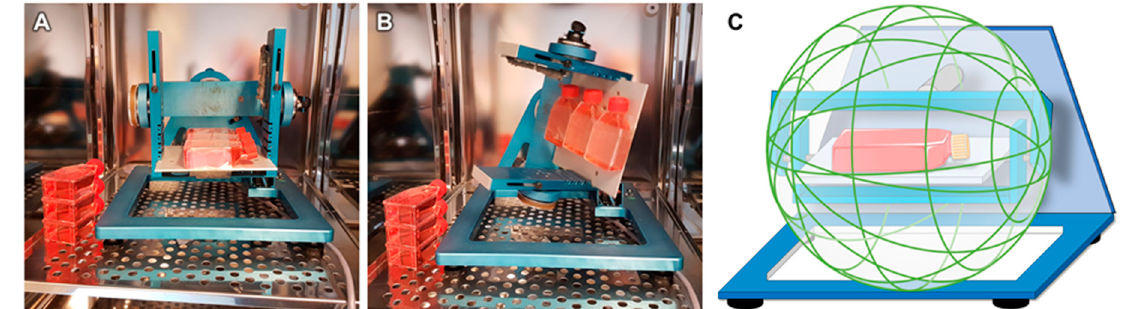
Figure 8. Experimental setup with the Random Positioning Machine (RPM). ( A ) The desktop-RPM (developed by AIRBUS Defence & Space, former: Dutch Space) is placed inside a standard incubator and was loaded with cells in bubble-free filled cell culture flasks. ( B ) After starting, it simulates microgravity by random rotation around two axes. The 1 g controls were placed next to the RPM. ( C ) The working principle of the RPM in real random mode. Parts of the figure were drawn by using